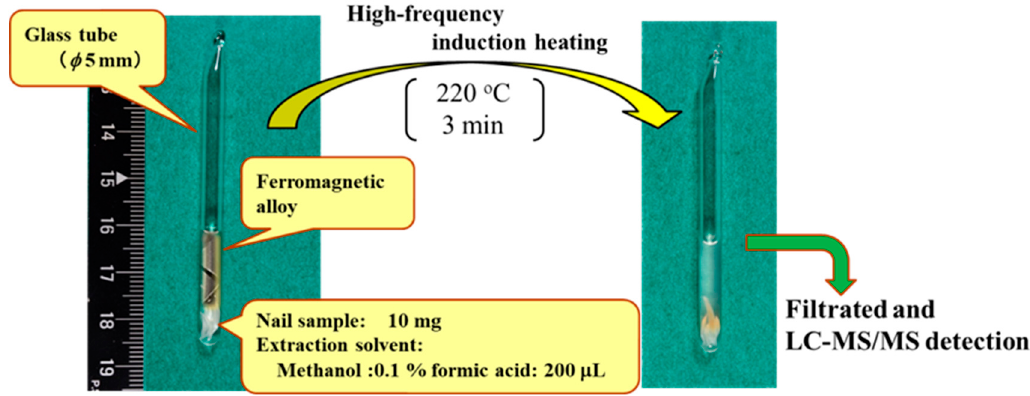
Figure 8. Schematic diagram of the high-frequency (H-F) heating extraction method.